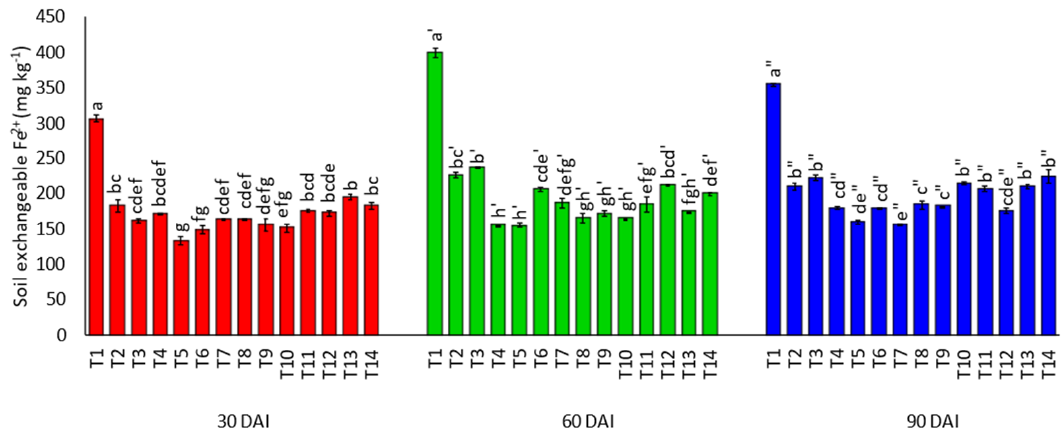
Figure 8. Effects of treatments on soil exchangeable ferrous ions after thirty, sixty, and ninety days of incubation, where T1: soil alone, T2: Egypt rock phosphate alone, T3: Egypt rock phosphate + 100% charcoal, T4: Egypt rock phosphate + 100% sago bark ash, and T5: Egypt rock phosphate + 100% charcoal + 100% sago bark ash, T6: Egypt rock phosphate + 75% charcoal + 75% sago bark ash, T7: Egypt rock phosphate + 50% charcoal + 75% sago bark ash, T8: Egypt rock phosphate + 25% charcoal + 75% sago bark ash, T9: Egypt rock phosphate + 75% charcoal + 50% sago bark ash, T10: Egypt rock phosphate + 50% charcoal + 50% sago bark ash, T11: Egypt rock phosphate + 25% charcoal + 50% sago bark ash, T12: Egypt rock phosphate + 75% charcoal + 25% sago bark ash, T13: Egypt rock phosphate + 50% charcoal + 25% sago bark ash, and T14: Egypt rock phosphate + 25% charcoal + 25% sago bark ash. Means with different letter(s) within the same incubation period indicate significant differences between treatments according to Tukey’s HSD test at p ≤ 0.05, i.e., a > b > c. Bars represent the mean values ± SE.